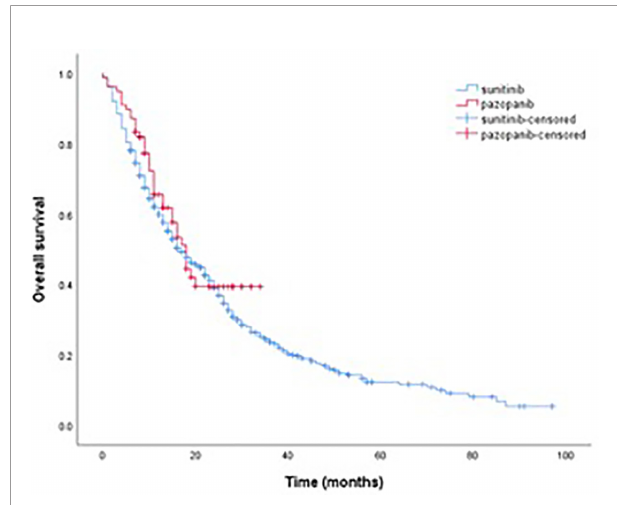
FIGURE 2 | Kaplan – meier estimate of OS for fi rst-line sunitinib and